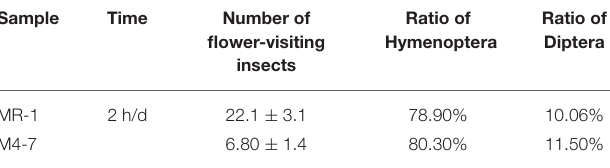
TABLE 1 | Visitation of flower visiting insects in melons with different stigma colors. Sample